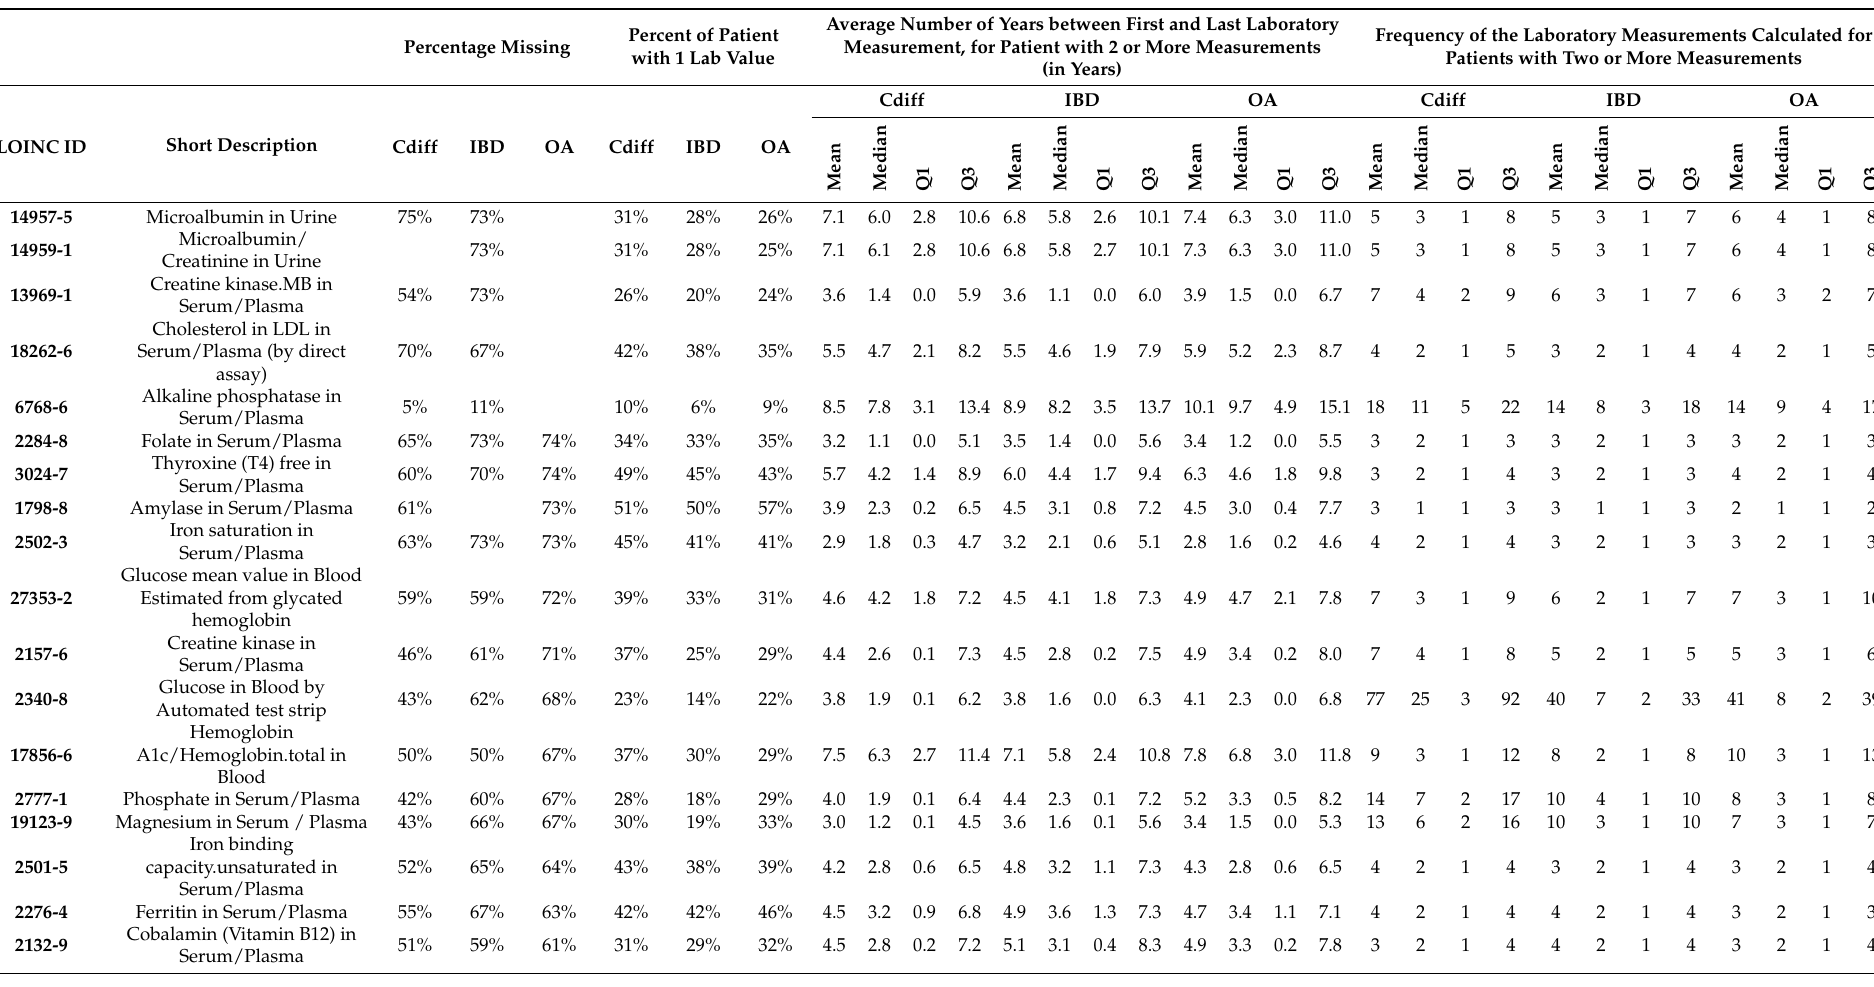
Table A2. Various summary statistics for the laboratory variables included in this study. The empty cell represents a percentage missing that is higher than 75%. Average Number of Years between First and Last Laboratory Percent of Patient Frequency of the Laboratory Measurements Calculated for Percentage Missing Measurement, for Patient with 2 or More Measurements with 1 Lab Value Patients with Two or More (in Years)